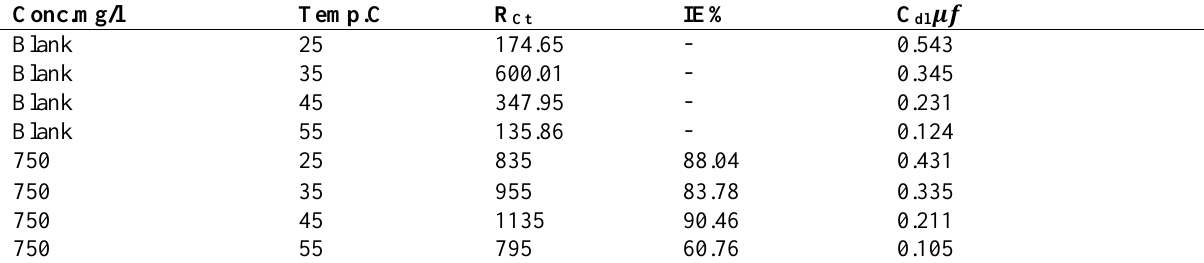
Values of the EIS test for absence and presence of Cloxacillin.